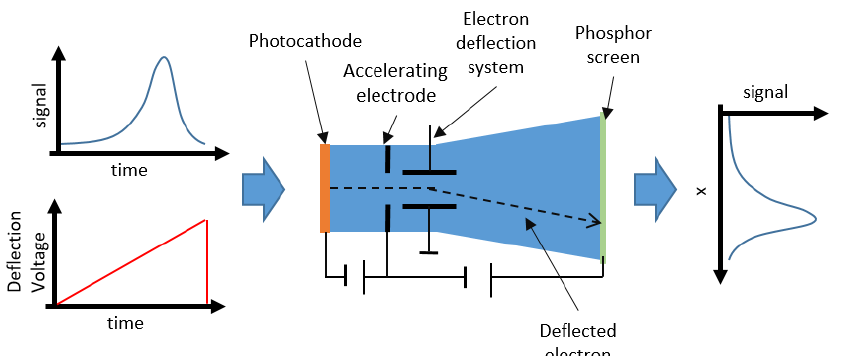
Figure 21. Working scheme of a streak camera. Through modulation of the electron deflection voltage, the deflection of the electrons emitted by the photocathode converts the time axis onto a spatial coordinate along the sweeping direction. If the entrance signal is a spectrum obtained by a dispersive medium, the streak camera allows one to resolve the intensity of the spectrum with time resolution as short as 200